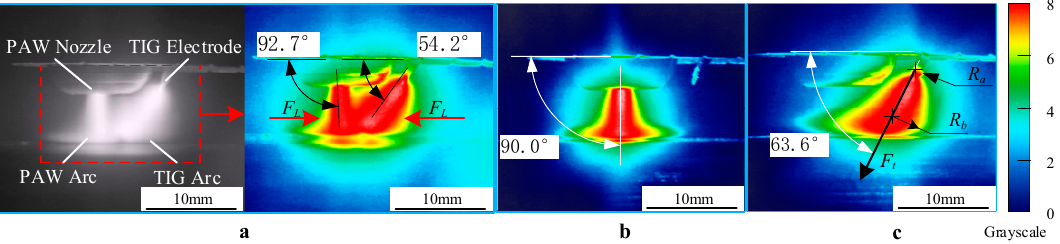
Figure 4. Schematic of the behavior on the plasma arc images of arc profile of different welding method. ( a ) Coupled arc welding. ( b ) Plasma arc welding. ( c ) TIG arc welding.